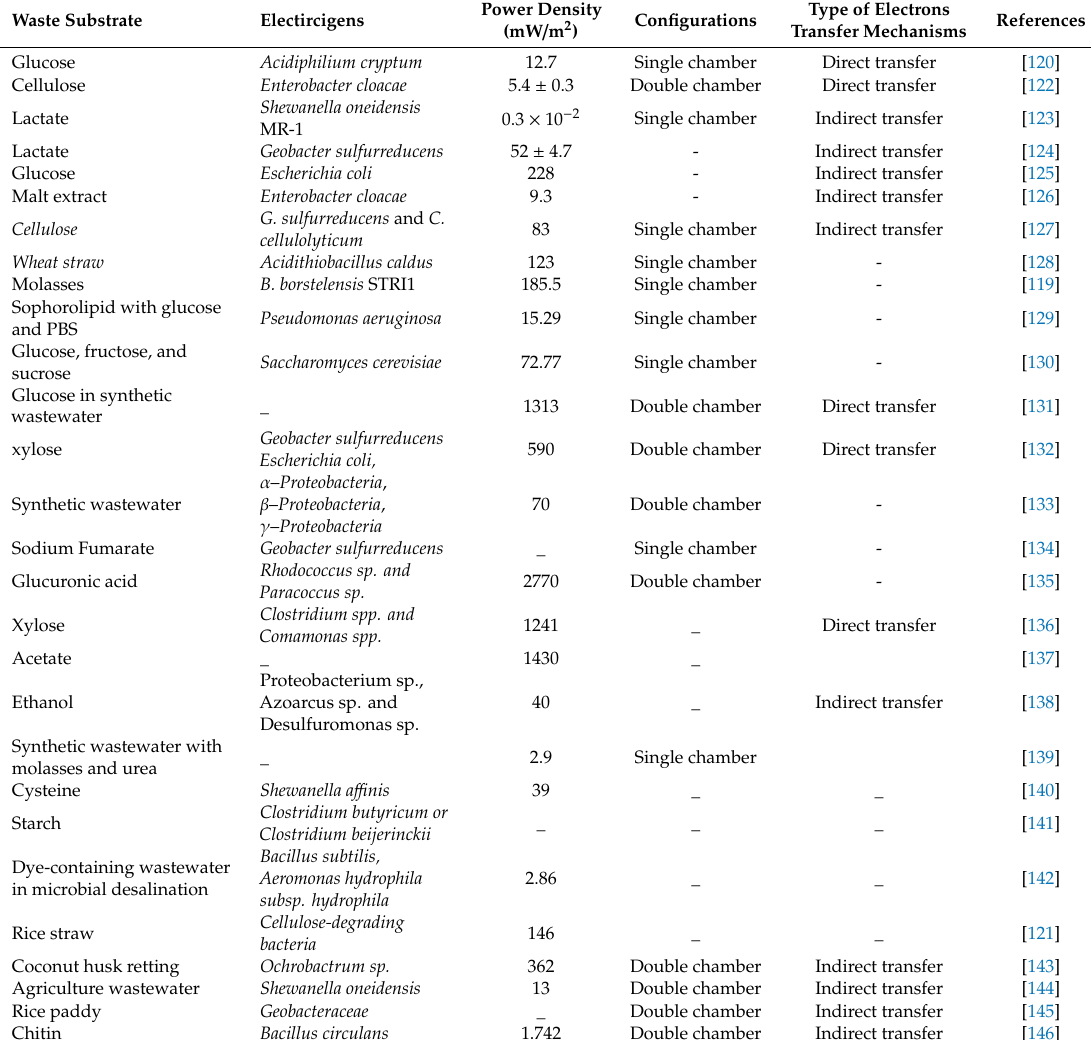
Table 2. Di ff erent substrates used in the BMFCs with corresponding power